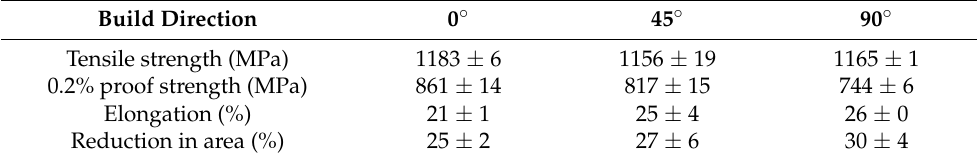
Figure 12. Stress–strain curves of the as-built specimens fabricated in the direction of 0 ◦ (horizontal direction on the base plate), 45 ◦ , and 90 ◦ (vertical direction on the base plate). Table 5. Mechanical properties of the as-built specimens fabricated at the optimum